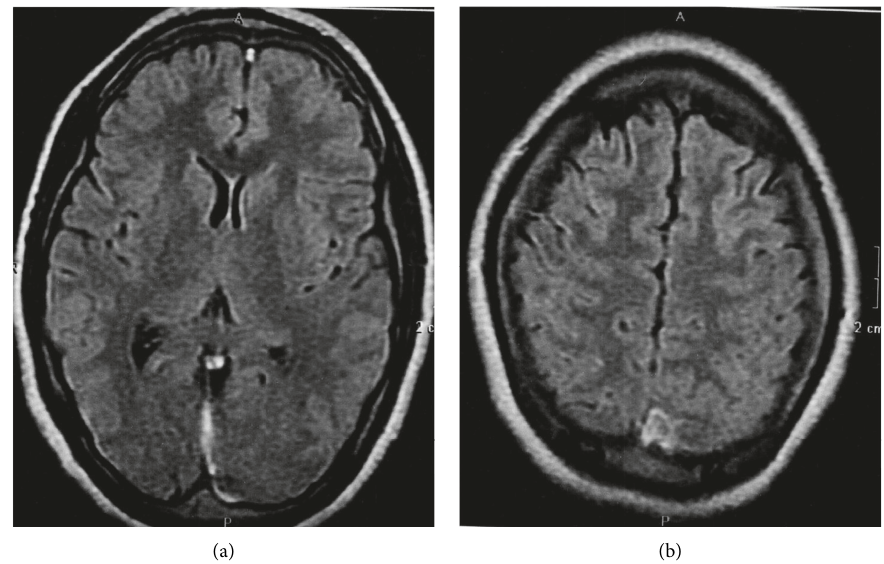
Figure 1: Brain MRV scan. (a) Almost complete absence of the intensity (supra-tentorial) in the left transverse, and the occipital venous sinuses. (b) Almost complete absence of the intense in the sagittal venous